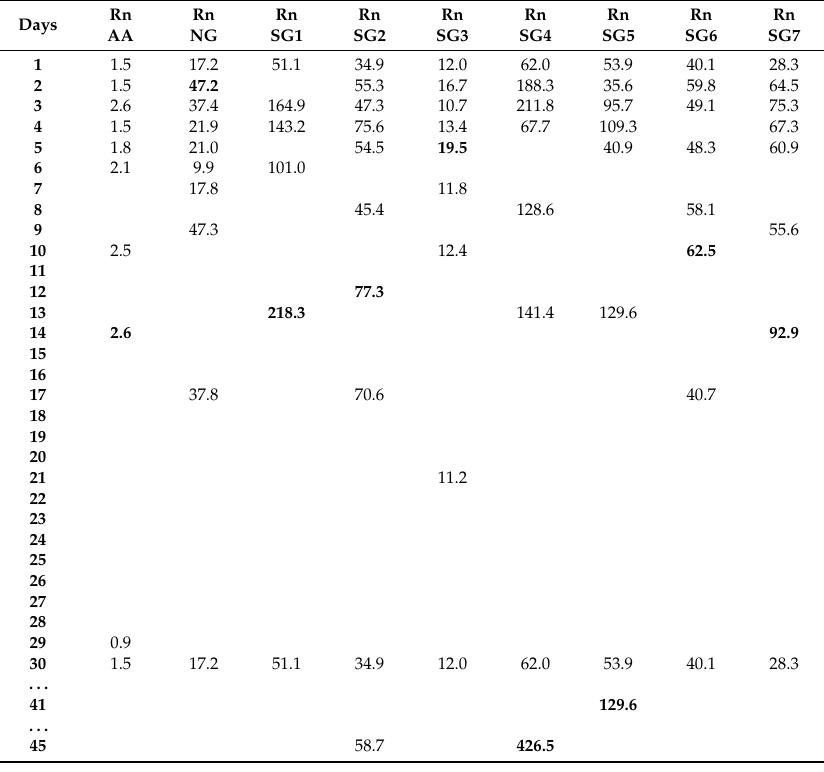
Table A3. Modified Fourier analysis for Rn in AA, NG and SG 1-7 (4-W samples). Maxima of amplitude are highlighted in